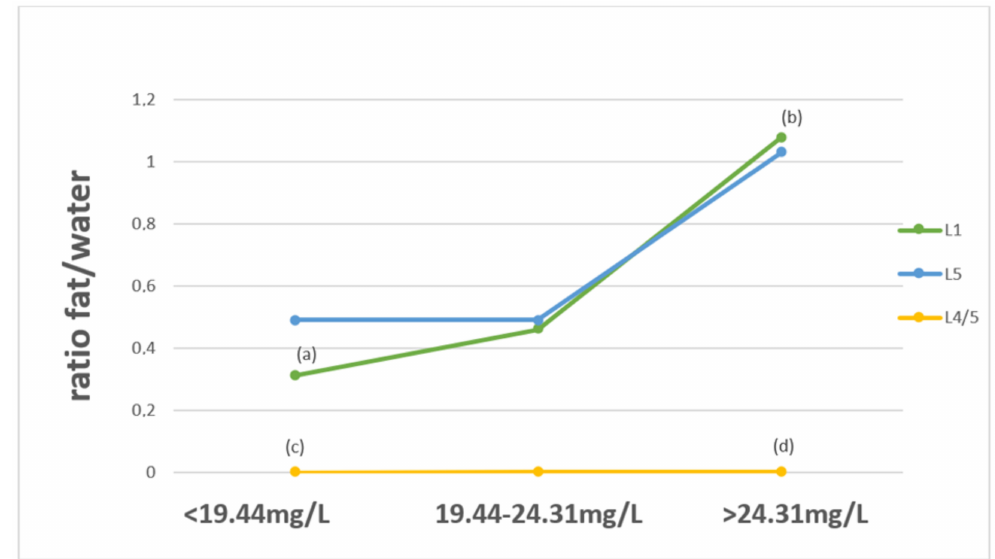
Figure 2. Fat/water ratio of selected spine structures in 1 H-MRS, divided into serum Mg concen- trations below, within and above the norm. Significant differences ( p < 0.05) for ( a ) vs. ( b ) in the L1 vertebral body and for ( c ) vs. ( d ) in the L4/L5 intervertebral